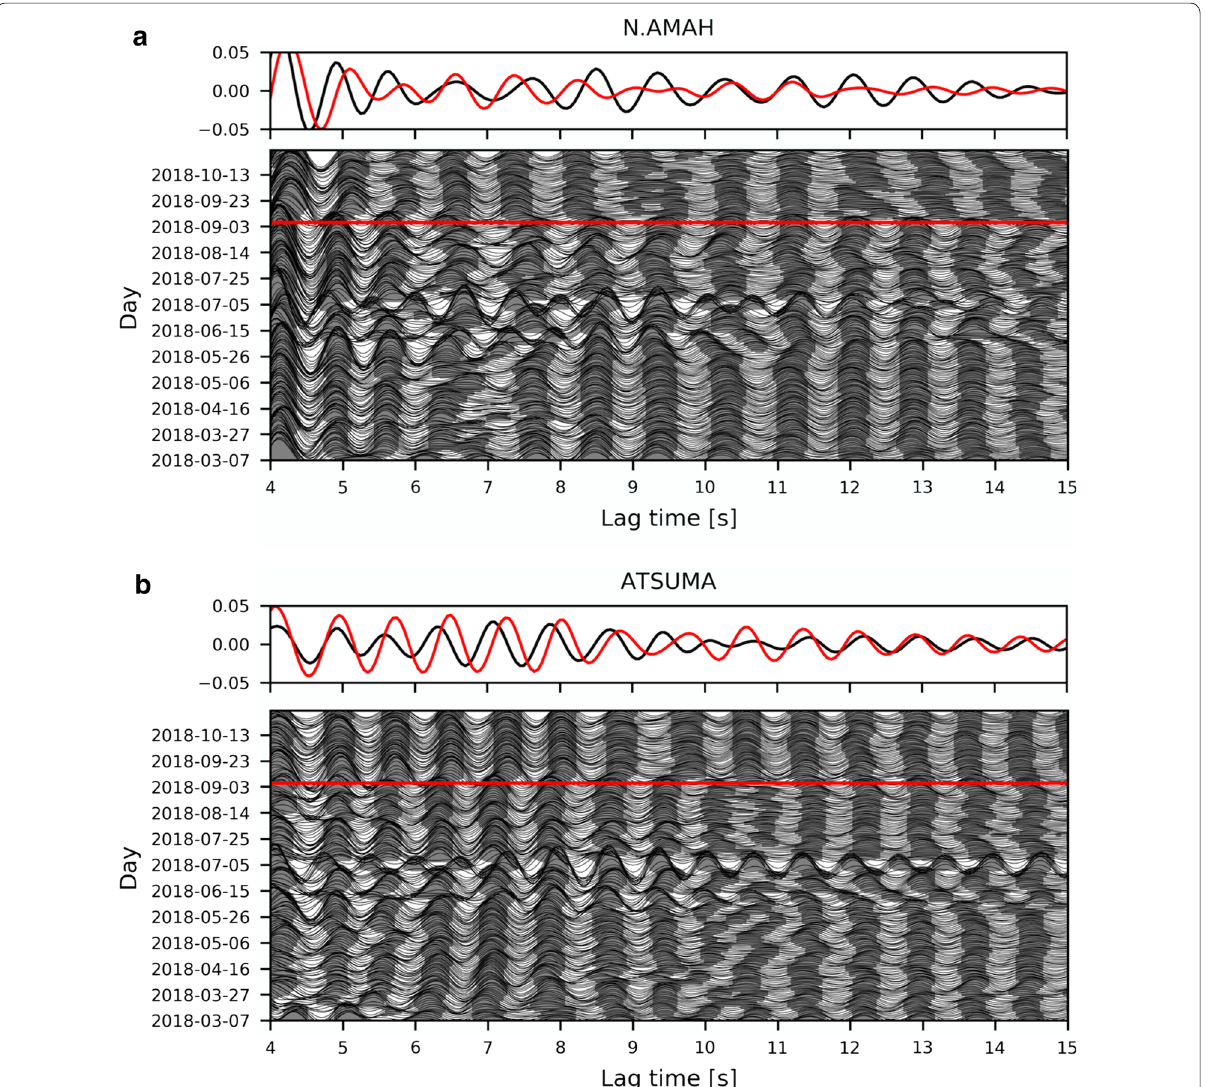
Fig. 2 Calculated ACFs at a N.AMAH, and b ATSUMA seismic stations. The top panels show the averaged ACFs before (black) and after (red) the mainshock. The bottom panels show the 7-day averages of the ACFs. The red line in the bottom panels indicates the day the mainshock